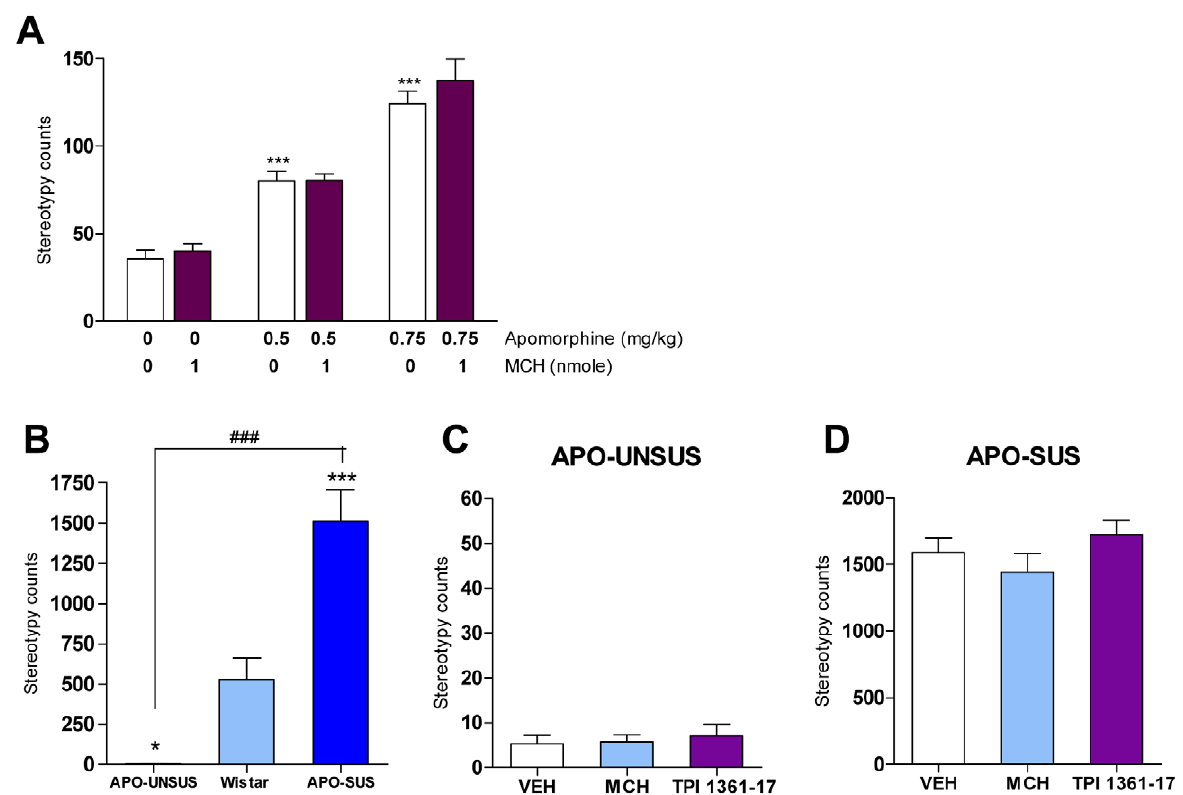
Figure 5. Apomorphine-induced stereotyped behaviors upon MCH injection. A. Effect of MCH (0, 1 nmole) on apomorphine (0, 0.5, 0.75 mg/kg)-induced stereotyped behaviors in mice (*** p , 0.001 vs. VEH, two-way ANOVA with Bonferroni test; n=5–10). B. Stereotypy counts in APO-UNSUS, wild type Wistar and APO-SUS rats after apomorphine (1.5 mg/kg) injections (* p , 0.05 *** p , 0.001 vs Wistar ### p , 0.001 vs APO- UNSUS, one-way ANOVA with bonferroni’s posttests; n=10–15). C. Effect of MCH (10 nmole) and TPI 1361-17 (10 nmole) on apomorphine (1.5 mg/ kg)-induced stereotyped behavior in APO-UNSUS rats (n=10–13). D. Effect of MCH (10 nmole) and TPI 1361-17 (10 nmole) on apomorphine (1.5 mg/ kg)-induced stereotyped behavior in APO-SUS rats (n=11–13). Values (A–D) represent total stereotypy counts 6